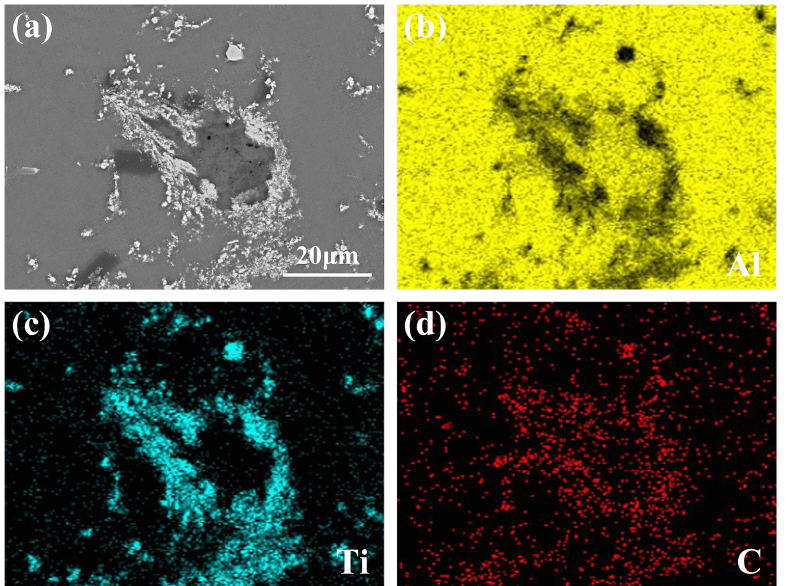
Figure 6. EDS mapping analysis of the core–shell phase of Al-4Ti-1C prepared by 30 μ m graphite: ( a ) microstructure and ( b – d ) mapping micrographs for Al, Ti, and C elements.